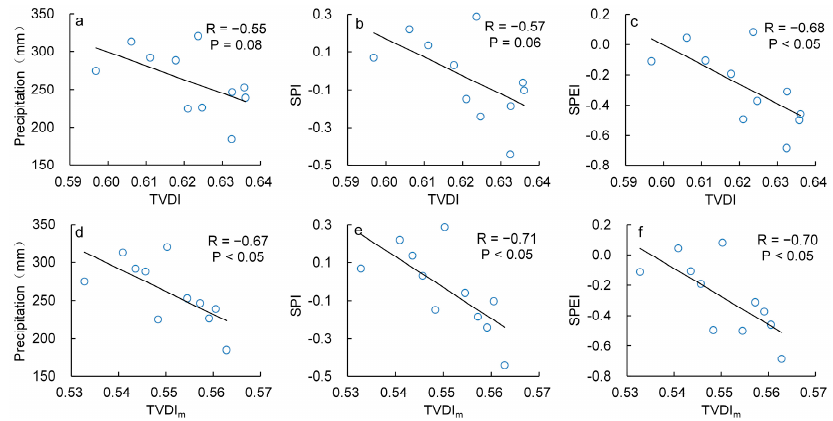
Figure 12. The scatterplots and correlation coefficient R values between TVDI and precipitation ( a ); TVDI and SPI ( b ); TVDI and SPEI ( c ); TVDI m and precipitation ( d ); TVDI m and SPI ( e ); and TVDI m and SPEI ( f ).